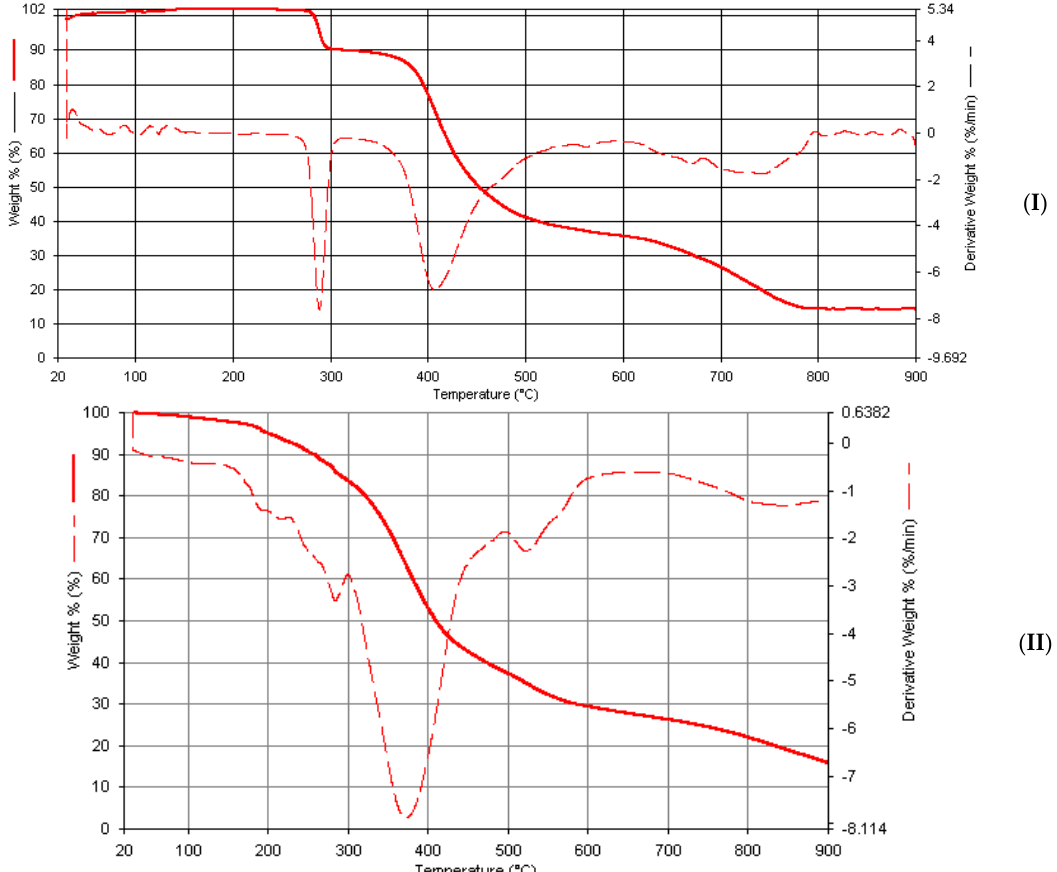
Figure 14. Thermogravimetric analysis curves of metal complexes. ( I ) Cu(Bmpp-Ph) 2 (H 2 O) 2 ∙ H 2 O; and ( II ) Cu(Ampp-Ph) 2 (H 2 O) 2 .